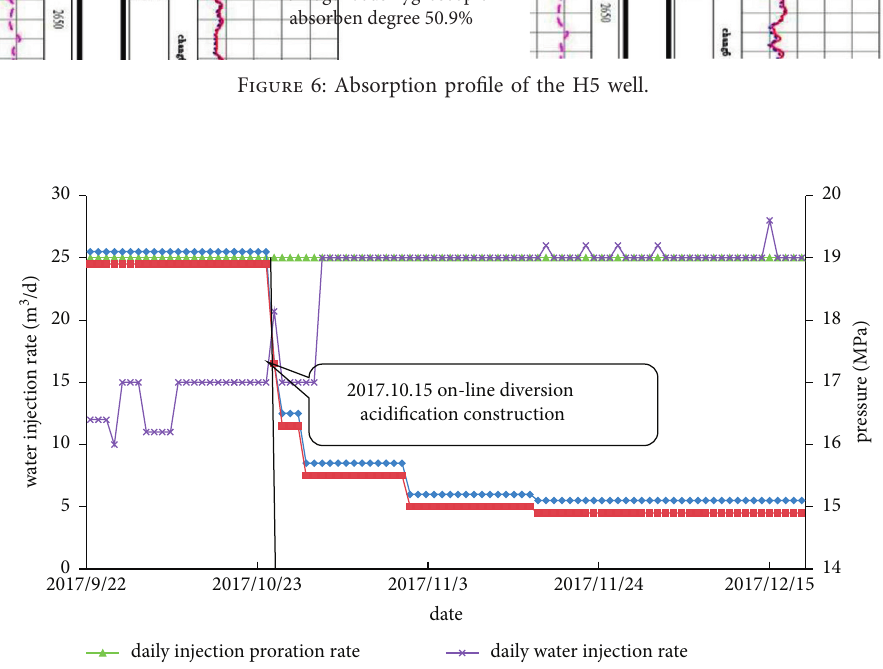
Figure 7: The water injection curve of the H5 well before and after online diversion acidification.